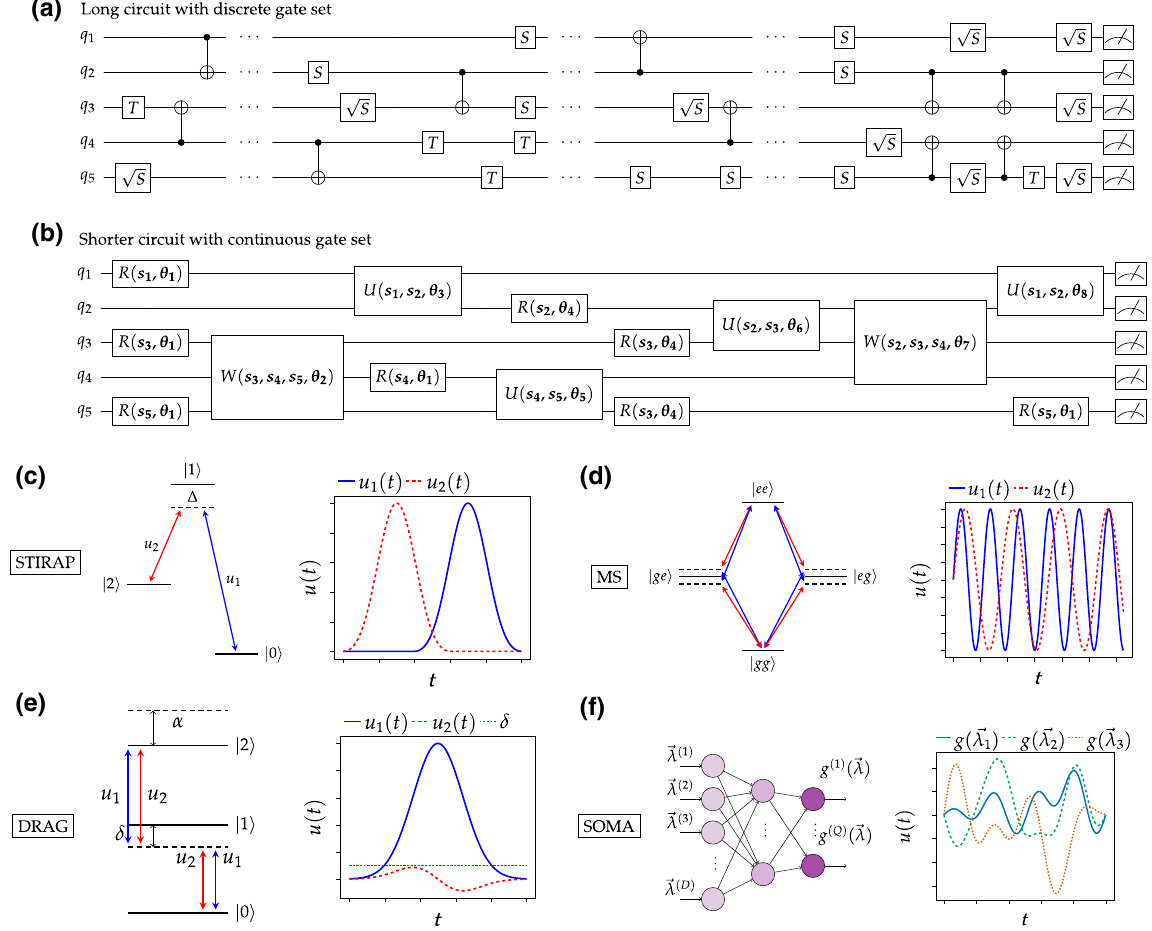
FIG. 1. An explanatory diagram of the concepts discussed in Sec. II. (a) A general quantum circuit containing a long sequence of discrete unitaries (Clifford + T set), which do not exhibit any dependence on continuous parameters. (b) A general quantum circuit con- taining different unitaries with different continuous parameters s 1 , s 2 , . . . , s 5 for different qubits q 1 , q 2 , . . . , q 5 and angles θ 1 , θ 2 , . . . , θ 8 parametrizing each gate. R , U , and W represent an analog single-, two– and three-qubit gate, respectively. Here, the same unitary parametrization is capable of representing all the different gates needed in the circuit. We show some notable analytical solutions used to engineer specific gate operations, which are usually implemented due to their adaptive character and simplicity [see Eqs. (5), (6), and (7)]. (c) STIRAP [31,32]. (d) The Mølmer-Sørensen gate [33,34]. (e) DRAG [35,36]. (f) The method that we propose, SOMA, does not make strict assumptions on how the pulse depends on the problem parameters but, rather, discovers it more generally through